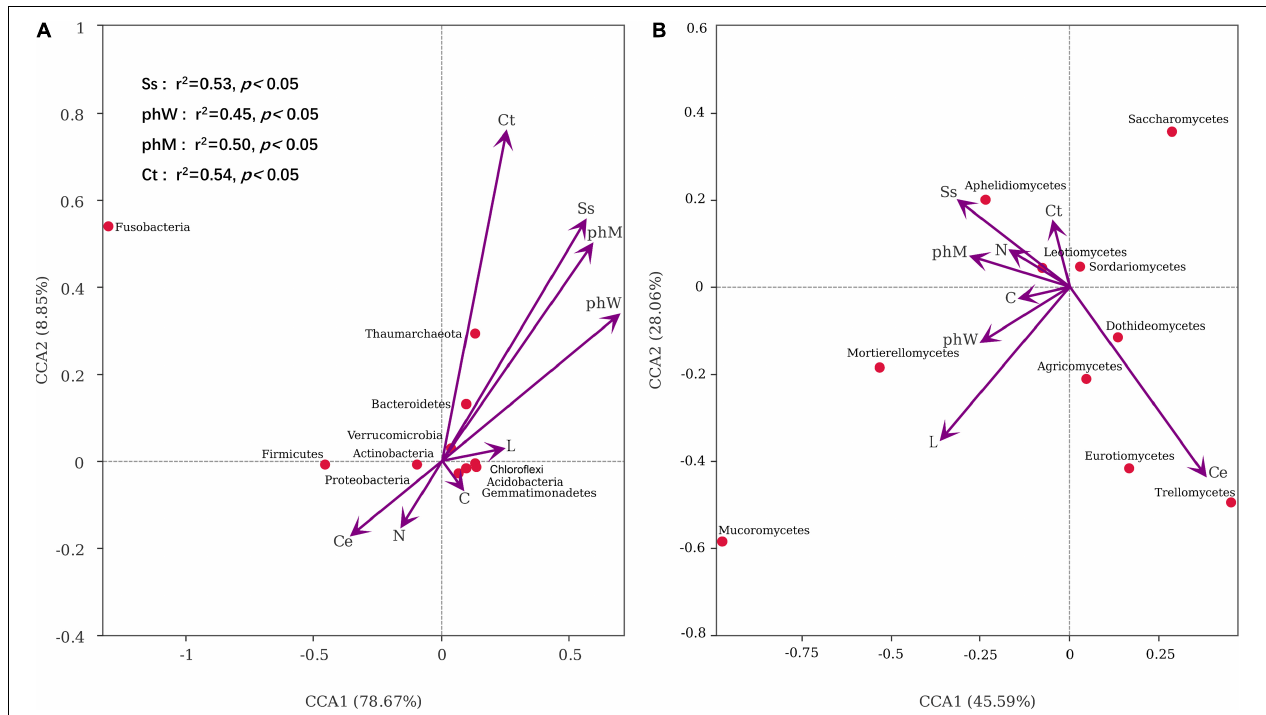
FIGURE 8 | Canonical Correspondence Analysis plots showing the relationships between (A) dominant bacteria phyla, (B) dominant fungi classes and litter chemical properties. The significant influences of litter chemistry across all samples were labeled ( p < 0.05).